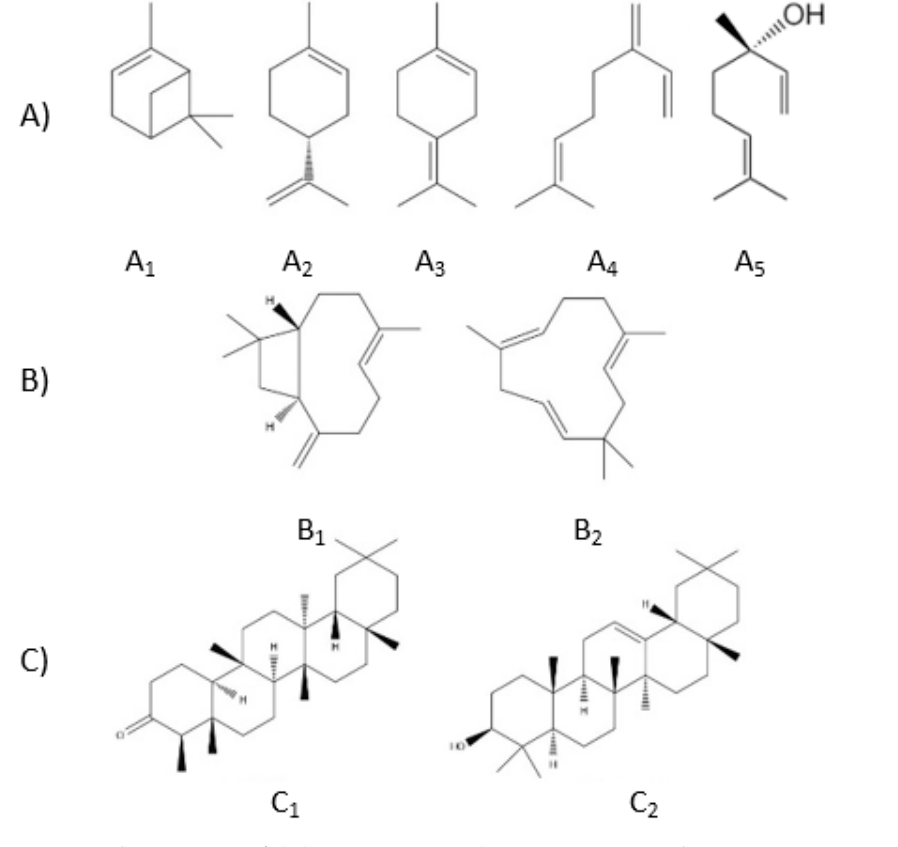
Figure 5. The structures of: ( A )—monoterpenes ( A 1 — α - pinene, A 2 —limonene, A 3 —terpinolene, A 4 — α - myrcene, and A 5 —linalool); ( B )—sesquiterpenes ( B 1 — β -caryophyllene and B 2 — α -humulene); and ( C )—triterpenes ( C 1 — f riedelin and C 2 — β -amyrin).